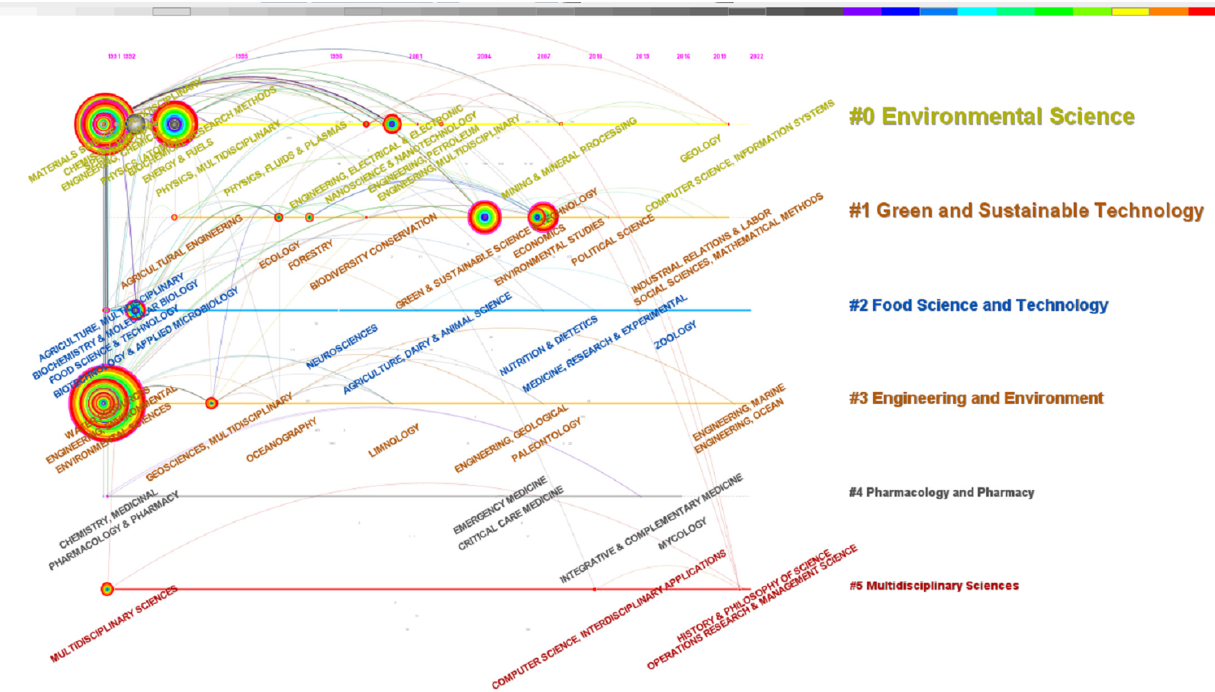
Figure 11. Timeline graph of categories.